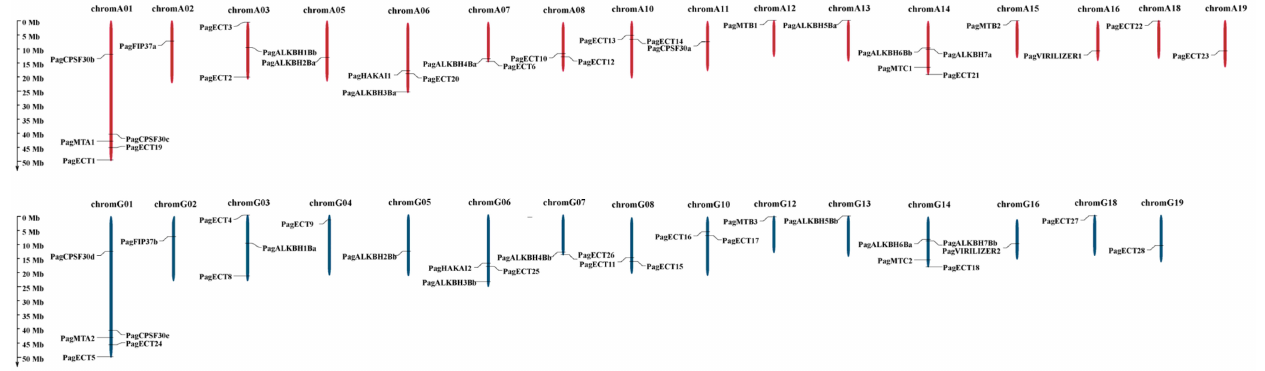
Figure 2. Genes location on chromosomes. The chromosomes in genome A are shown in red, and the chromosomes in genome G are shown in